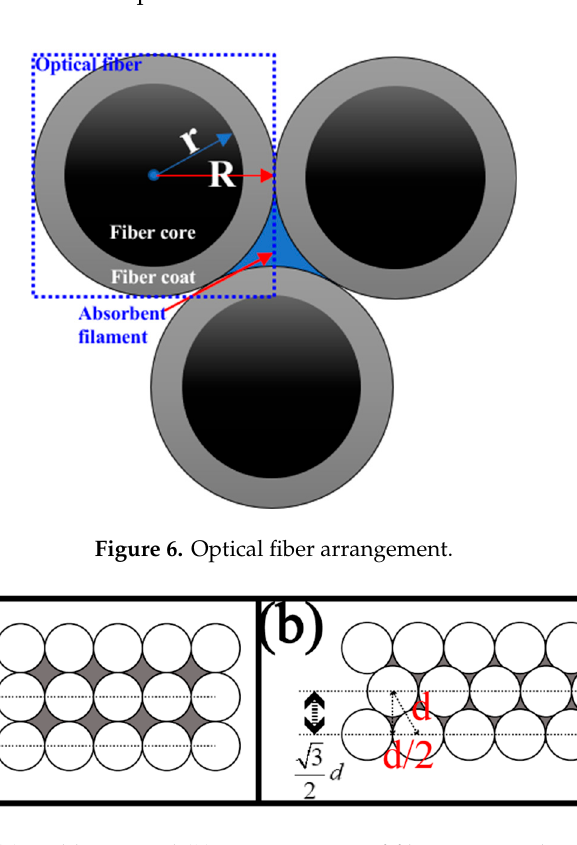
Figure 7 . The square (a) and hexagonal (b) arrangements of fiber cores in the FOA, where d is the radius of the fiber core. radius of the fiber